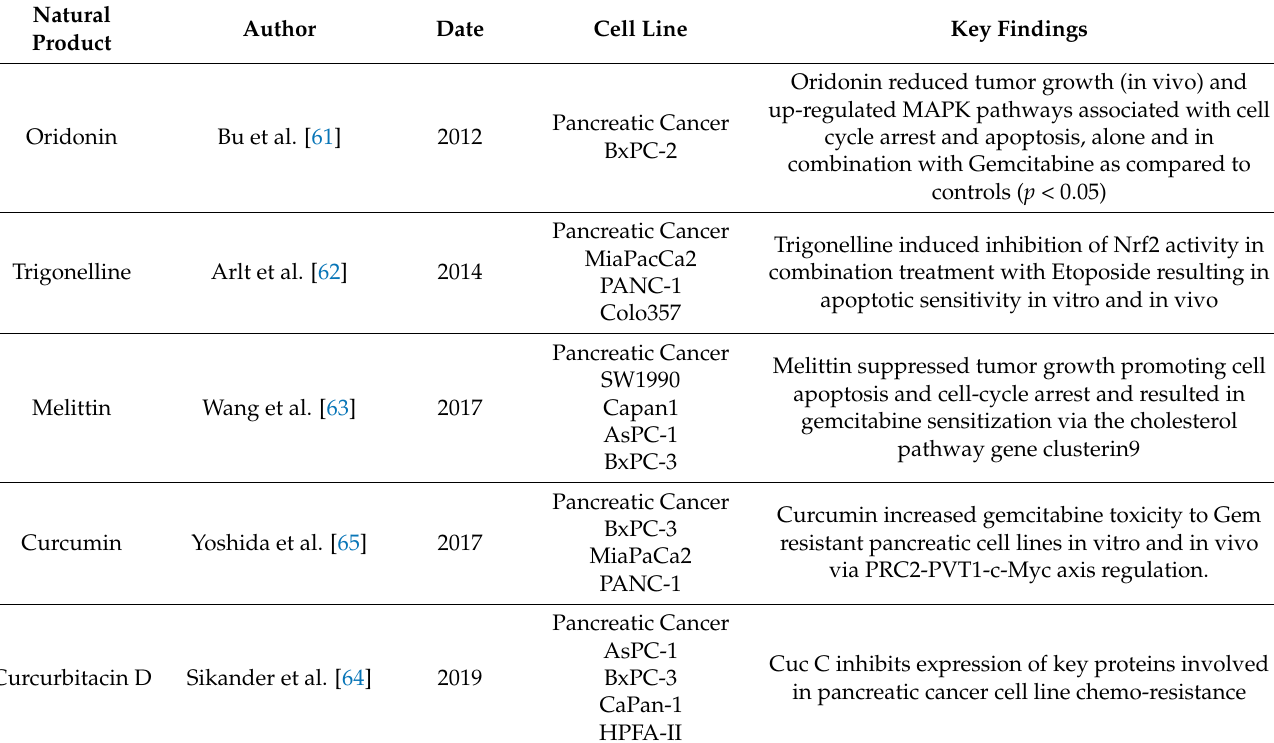
Table 2. Natural chemosensitizers for